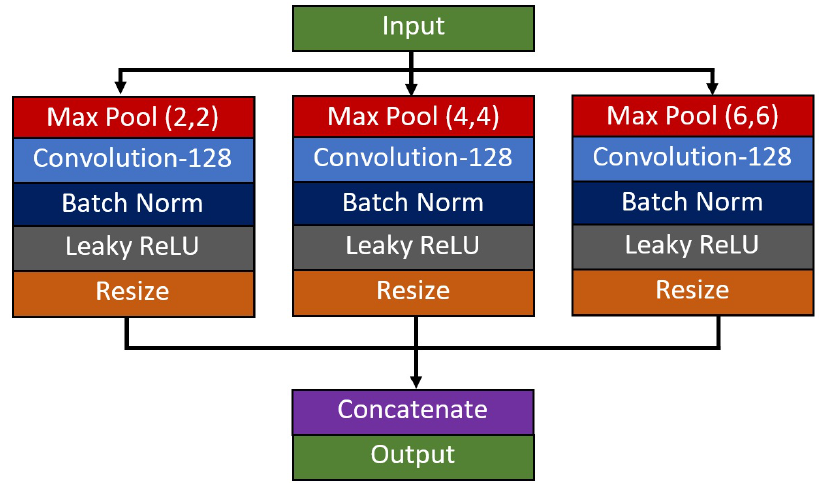
Figure 3. Architecture of the spatial pyramid pooling unit. Then, a standard global average pooling G operator is used to sample the best multi- scale features before the classification process is done using a dense feedforward layer. The full design of the Residual-Shuffle-Net architecture is given in Table 1, where each layer information is detailed out in terms of the filter size, kernel size, and stride step for all bottom, middle, and top modules. Let D represent the dense connection layer with three output classes, where a SoftMax activation function is applied to complete the Residual-Shuffle-Net classifier with a total of 2,090,491 parameters.